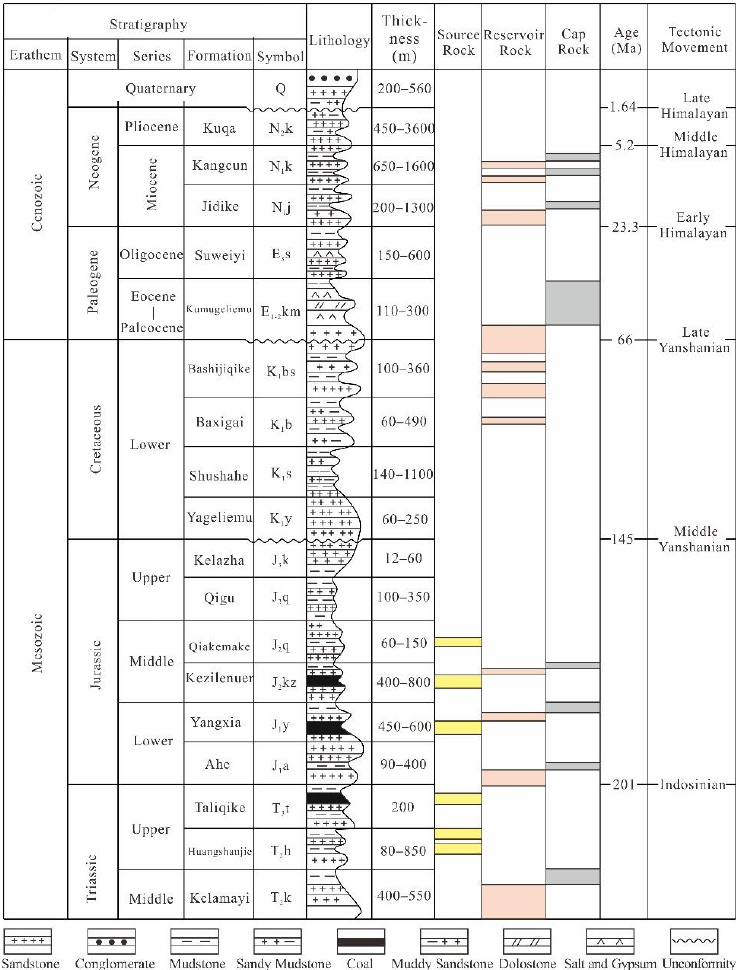
Figure 2. Mesozoic–Cenozoic stratigraphic system in the Dibei tectonic belt, Kuqa Depression (modified from Xiongqi Pang, 2019 [16] and Xiaowen Guo, 2016